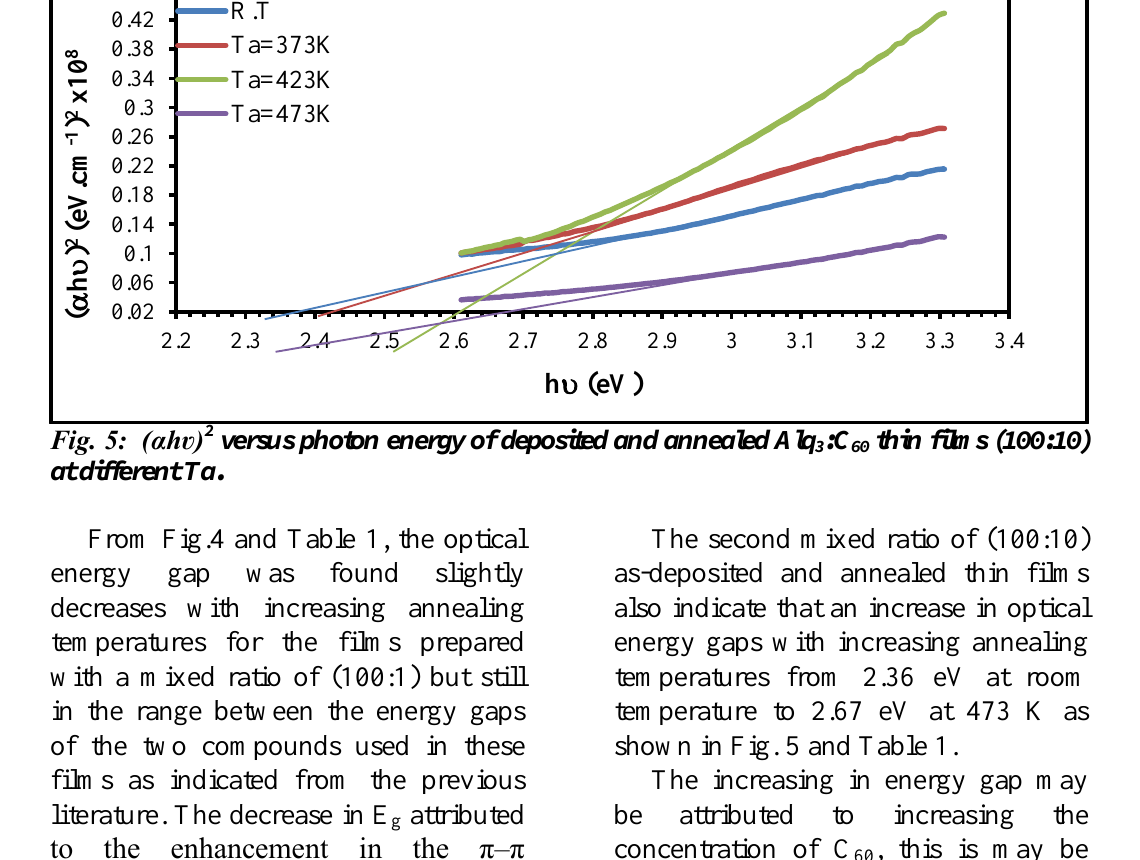
Table 1: The optical energy gaps of as-deposited and annealed Alq Alq :C 3